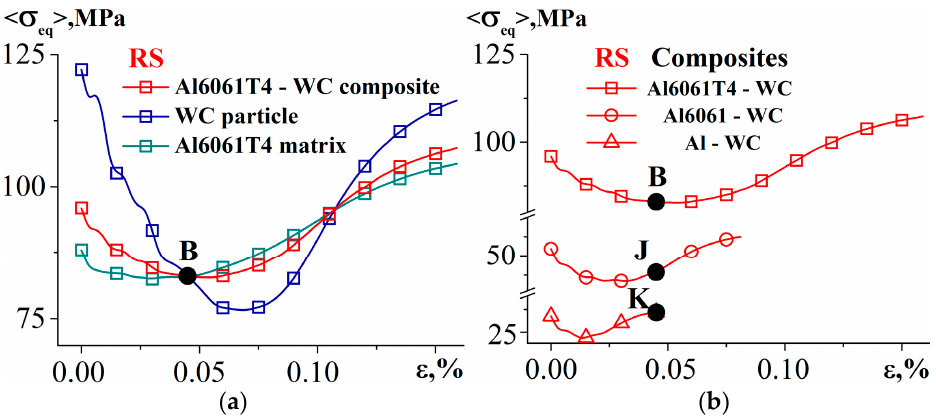
Figure 10. Stage 1 of the stress–strain curves of composites. Initial sections of the stress–strain curves of Al6061T4-WC composite, Al6061T4 matrix and WC particle ( а ), and the composites with di ff erent matrix materials ( b ). States В , J and K are shown in Figures 7–9 and